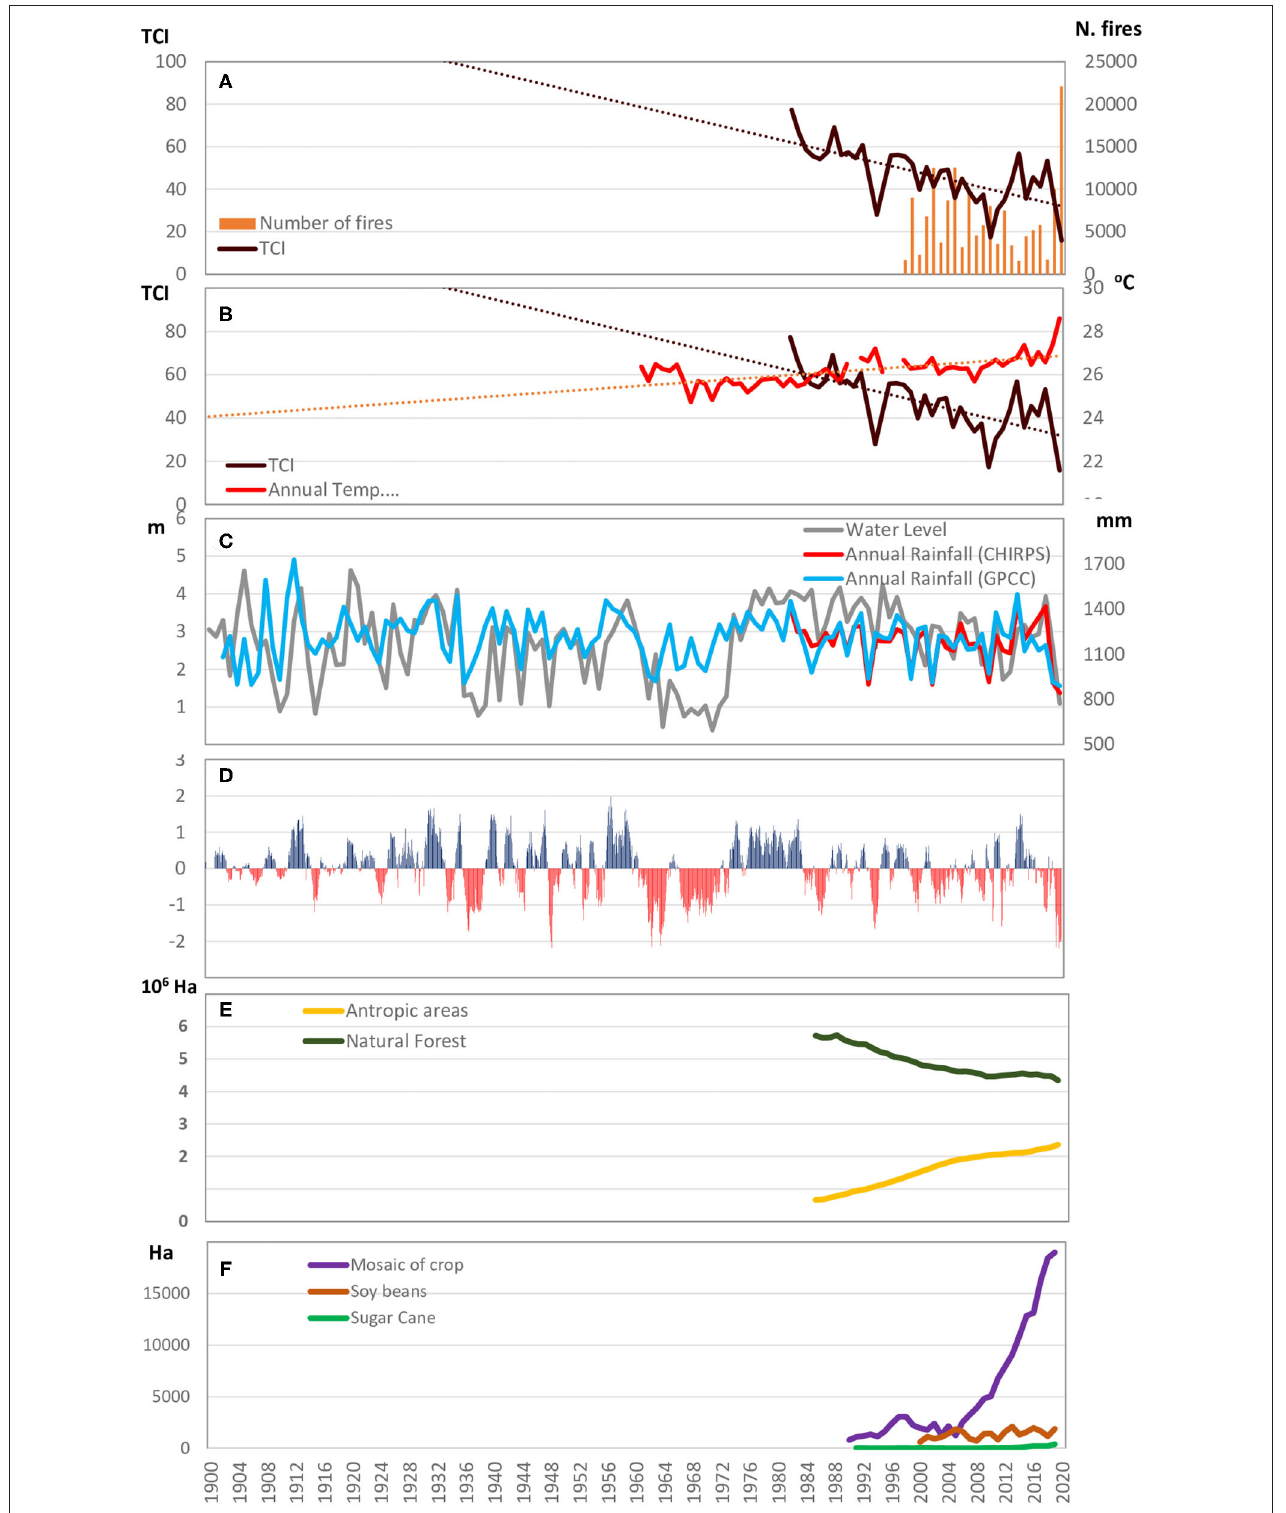
FIGURE 4 | Climate, hydrology, vegetation and land use trends in the Brazilian Pantanal from 1900 to 2020: (A) Number of fire episodes (INPE) and TCI; (B) TCI and air temperature (at Cuiabá station); (C) mean river levels at Ladário, mean annual rainfall from GPCC and CHIRPS, (D) SPI-12; (E) anthropic and natural vegetation areas; (F) area with mosaic of crops, soybean and sugar cane (Sources of data: INPE. Brazilian Navy, INMET, CEMADEN, MAPBIOMAS).